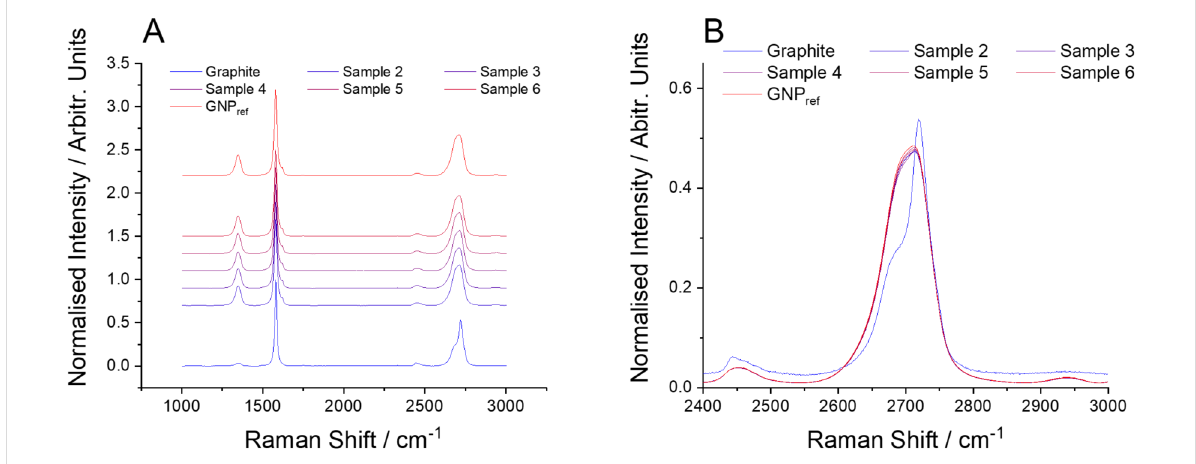
Figure 2: (A) Averaged spectra from samples of GNP ref with additions of graphite. The bottom spectrum (blue) is from graphite only. The top spec- trum (red) is from GNP ref only. All other spectra are mixtures of GNP ref and graphite. (B) Overlaid spectra showing the region of the 2D peak.